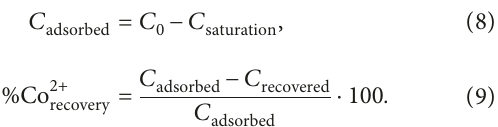
Figure 12: MCSG60A regeneration results using different acid solutions. Conditions: adsorbent dosage